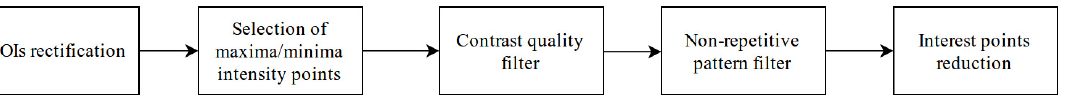
Figure 7. An overview of the interest point detection